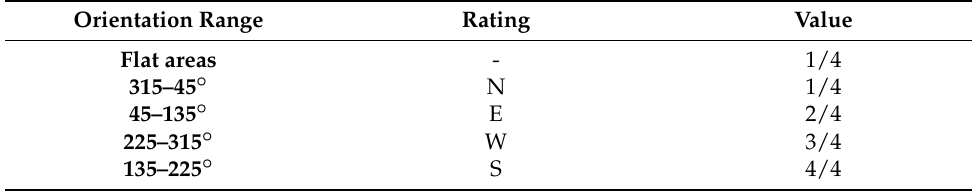
Table A12. Orientation assigned values.